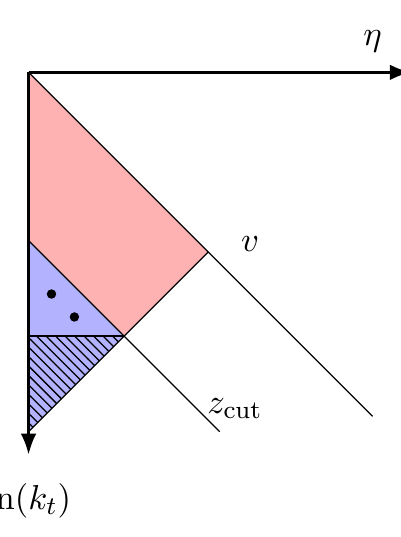
Figure 3. Lund diagram showing the region of phase space responsible for the independent emission clustering correction in blue. The region shown in red is the vetoed phase space responsible for the Sudakov factor. The two dots represent possible locations in the phase space for the pair of independent emissions which generate the clustering correction. Discussion of the hashed area, which contributes in principle to the clustering correction but turns out only to beyond NNLL accuracy, is postponed to later in this